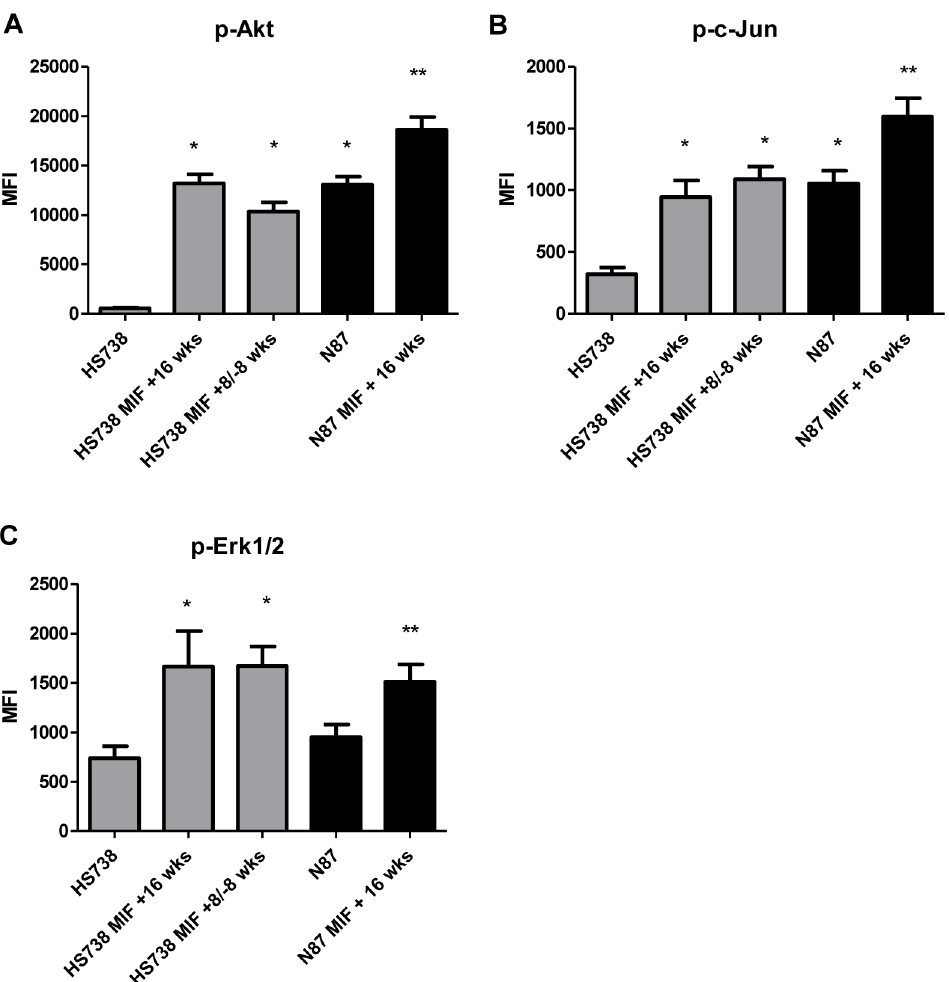
Figure 4. MIF induces pro-tumorigenic signaling. Chronic MIF treatment induces A) Akt, B) c-Jun, and C) Erk1/2 phosphorylation. N=8 and the mean 6 standard error are shown as the results of duplicated in multiple experiments. * p ,